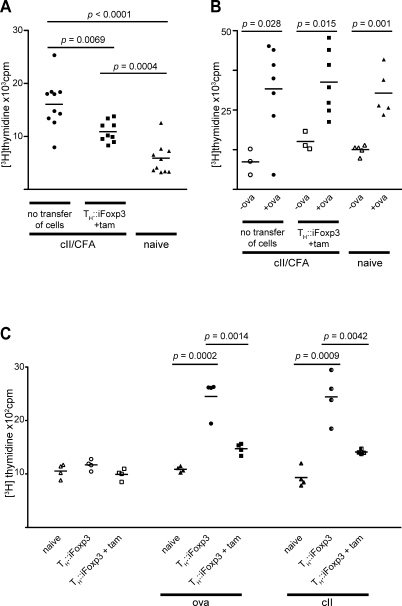
TH::iFoxp3 Cell-Mediated Suppression Is Specific(A and B) Mice were immunized with cII in CFA on day 0. tam, tamoxifen.(A) On day 35, ex vivo recall reactions to cII were performed on cells purified from mice that did not receive any further treatment (control, n = 10), mice that had received 1 × 106 TH::iFoxp3 cells and tamoxifen injections (TH::iFoxp3 + tam, n = 10), and naive mice (naive, n = 10).(B) Some of the mice described in (A) were immunized on day 28 with ova, and ex vivo recall reactions to ova were performed in parallel (control, −ova: n = 3, +ova: n = 7; TH::iFoxp3 + tam, −ova: n = 3, +ova: n = 7; and naive, −ova: n = 5, +ova: n = 5).(C) Mice were immunized simultaneously with cII and ova in CFA on day 0. Ex vivo antigen-specific recall reactions to ova (closed) and cII (half-closed) were performed on day 28. Mice that did not receive any further treatment (naive, n = 4), mice that received 1 × 106 TH::iFoxp3 cells and tamoxifen injections (TH::iFoxp3 + tam, n = 4), and mice that received 1 × 106 TH::iFoxp3 cells (TH::iFoxp3, n = 4) are shown. p-Values were determined using an unpaired t-test.